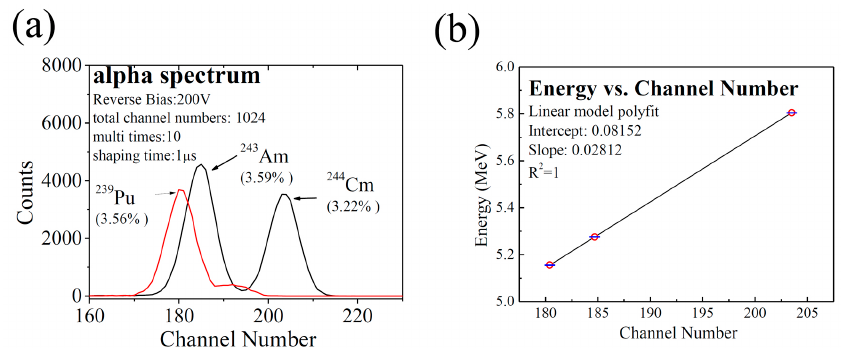
Figure 6. Response spectra of the 4H-SiC detector to the alpha particles from the sources of 239 Pu, 243 Am, and 244 Cm at a reverse bias of 200 V: ( a ) alpha counts as a function of channel number; ( b ) linear fitting of alpha particles’ energy vs. channel number of peak centroid.